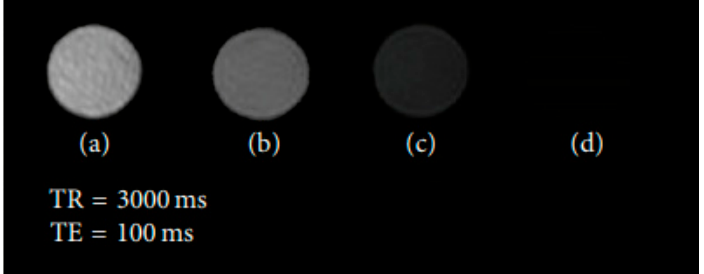
Figure 10. T 2 -weighted MR pictures representing MPEG-PEI-SPIONs at various concentrations, namely ( a ) 0.063; ( b ) 0.125; ( c ) 0.250; ( d ) as well as 0.500 mg/mL. Reproduced from Zhang, Y.; Zhang, ( a ) 0.063; ( b ) 0.125; ( c ) 0.250; ( d ) as well as 0.500 mg / mL. Reproduced from Zhang, Y.; Zhang, L.; Song, X.; L.; Song, X.; Gu, X.; Sun, H.; Fu, C.; Meng, F. “Synthesis of Superparamagnetic Iron Oxide Gu, X.; Sun, H.; Fu, C.; Meng, F. “Synthesis of Superparamagnetic Iron Oxide Nanoparticles Modified Nanoparticles Modified with MPEG-PEI via Photochemistry as New MRI Contrast Agent.” J. with MPEG-PEI via Photochemistry as New MRI Contrast Agent.” J. Nanomater. (2015) Nanomater. (2015) 417389.